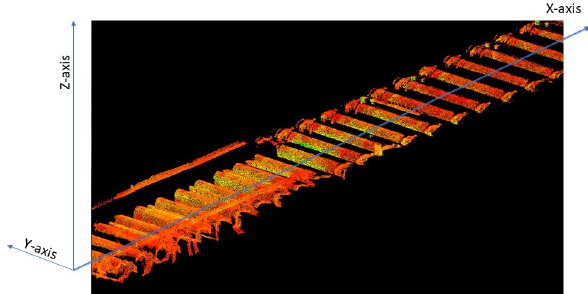
Figure 5. Point cloud of the rollers in a steel mill and the coordinate reference frame.